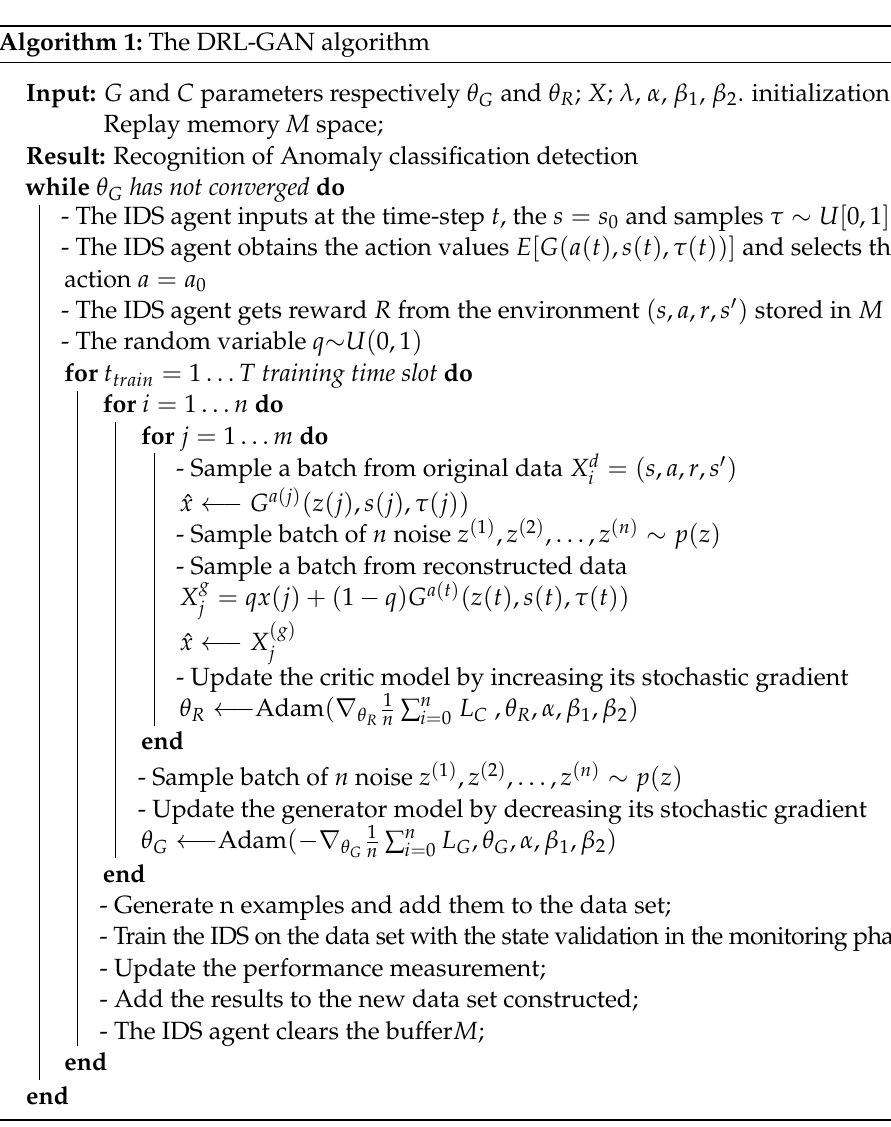
Algorithm 1: The DRL-GAN